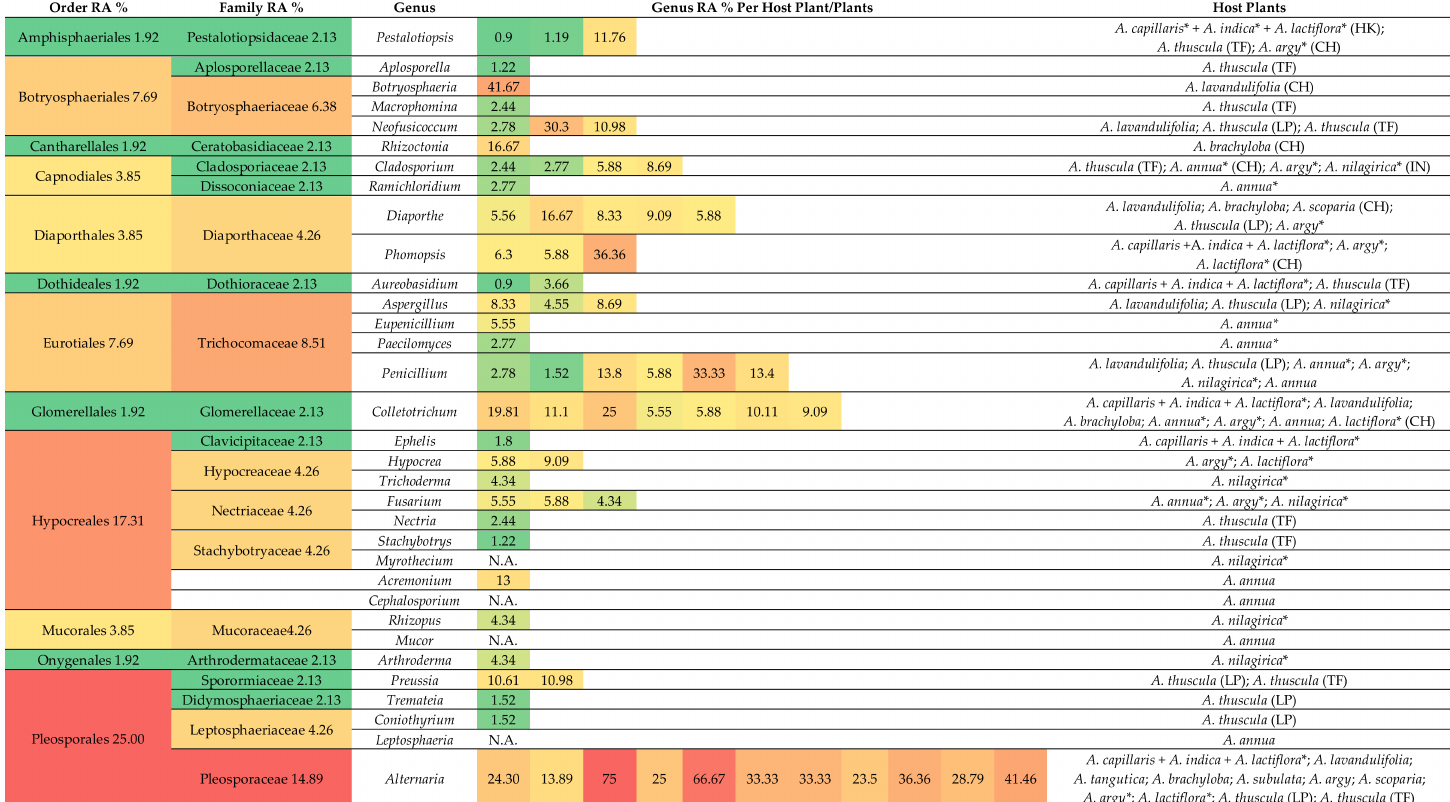
Table 1. Endophytic fungi order, family, genus and host plants with values of relative abundance (RA) for genus, family, and order. Values are represented using a color scale with green representing the smallest value and red the highest